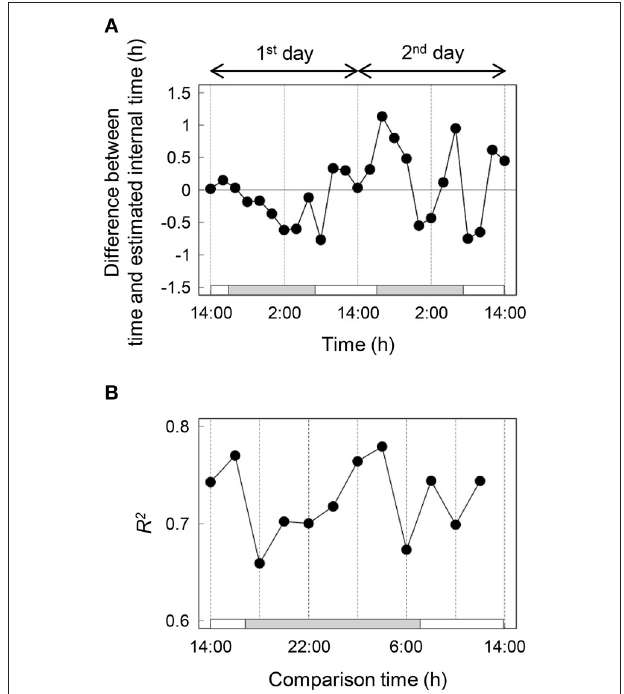
FIGURE 3 | Validation of the internal time estimation (A) and transition of the determination coefficient between normalized expression levels for the 1st and 2nd days (B). White and gray bars represent light and dark,